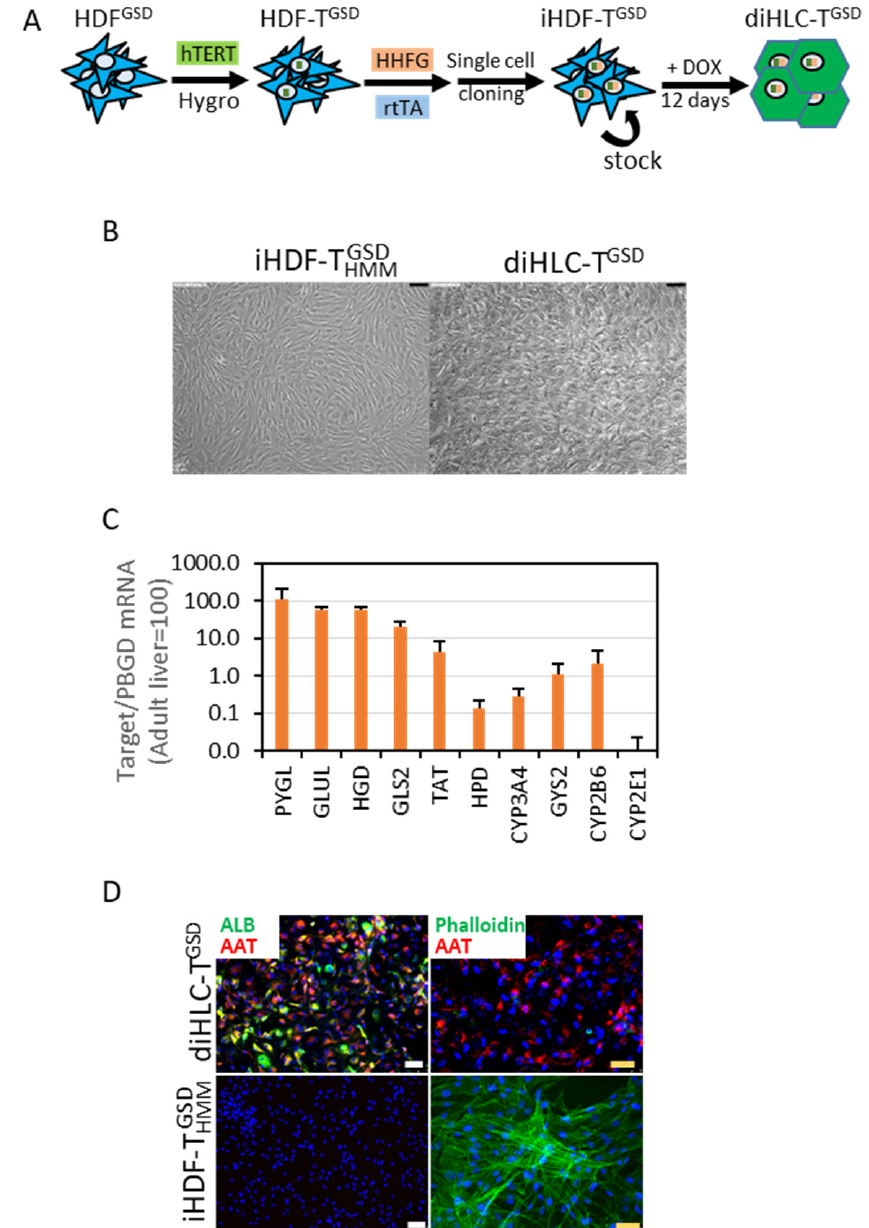
Figure 2. Doxycycline reprograms iHDF-T GSD into hepatocyte-like cells (diHLC-T GSD ). ( A ) A schematic representation of our reprogramming protocol. ( B ) Representative phase contrast images of iHDF-T GSD cultured for 12 days without (left panel) or with (right panel) 250 ng/mL doxycycline. The black bar equals 100 µ m. ( C ) mRNA level of multiple hepatic genes in diHLC-T GSD quantified by qRT-PCR, normalized to PBGD, and expressed relative to the levels in the adult human liver. Values correspond to the average of three different clones (six samples each). ( D ) Representative fluorescence images of cells immunostained with antibodies against human albumin and α 1-antitrypsin. Actin filaments were visualized by incubation with Alexa Fluor™ 488 Phalloidin. The nuclei were stained with DAPI. The white and yellow bars equal 75 µ m and 50 µ m, respectively.